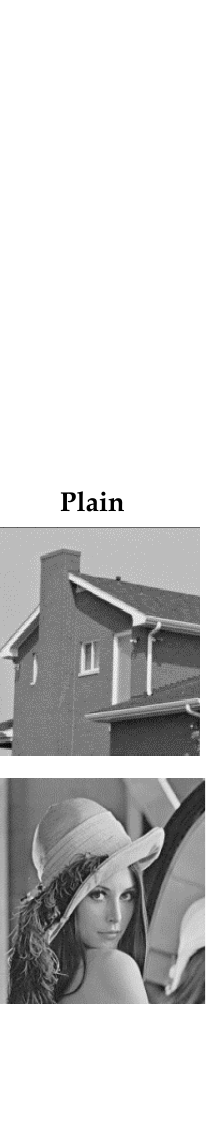
Figure 6. Key sensitivity analysis through various images: ( a ) Plain; ( b ) ciphered (E1); ( c ) ciphered (one-bit change in original key) (E2); ( d ) E1 XOR E2; ( e ) decrypted E1 with correct key; ( f ) decrypted E1 with an incorrect key.